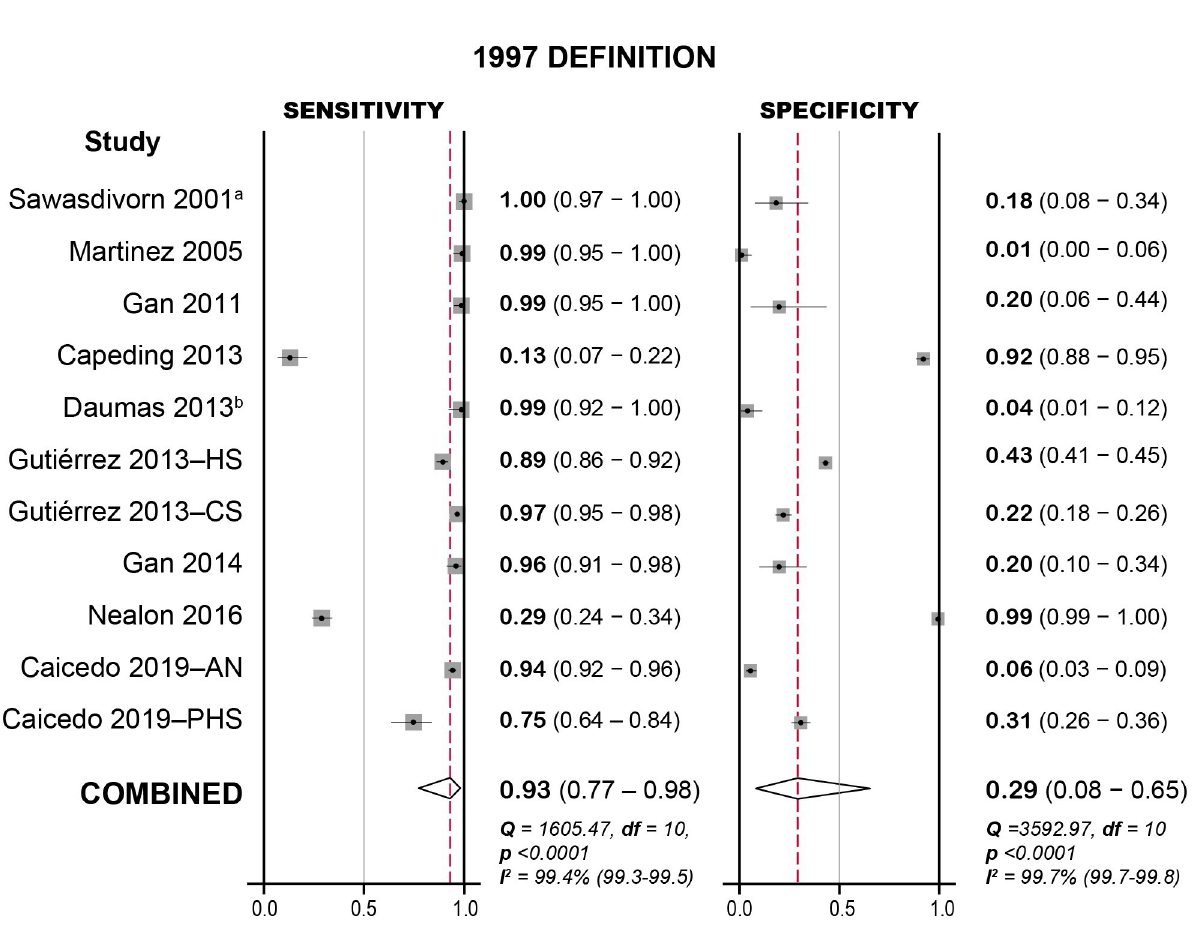
Fig 3. Forest plot for sensitivity and specificity of the WHO 1997 case definition for probable dengue. Meta-analysis carried out in Stata/IC 14 using the MIDAS statistical package. 95% confidence intervals given in parentheses. HS: hospital study; CS: cohort study; AN: Aedes Network Study; PHS: Public Health Surveillance Network Study. a: Calculated specificity differs from the reported value (0.2121); b: Calculated sensitivity differs from the reported value (0.98).